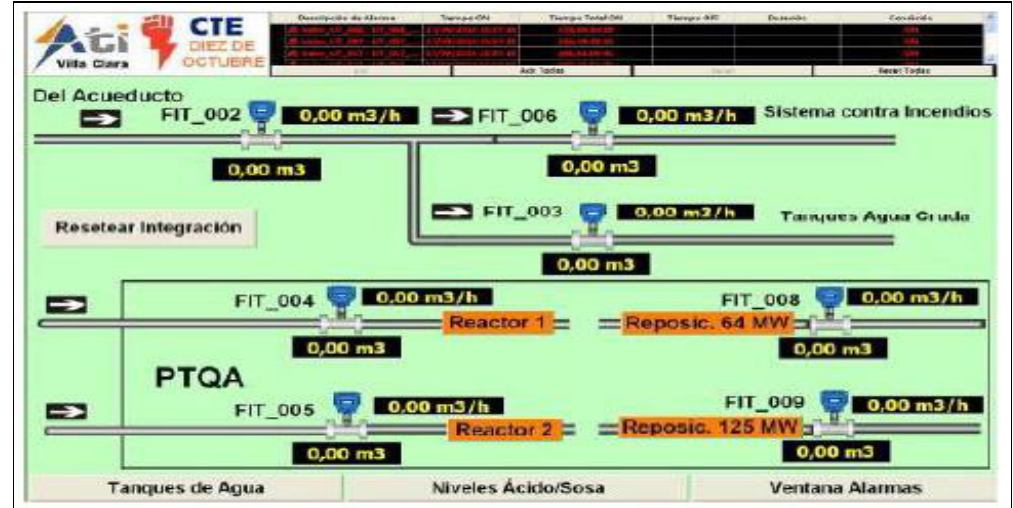
Figura 15: Una de las pantallas de la aplicación SCADA, usando Movicon, desarrollada para la planta de tratamiento químico de agua.